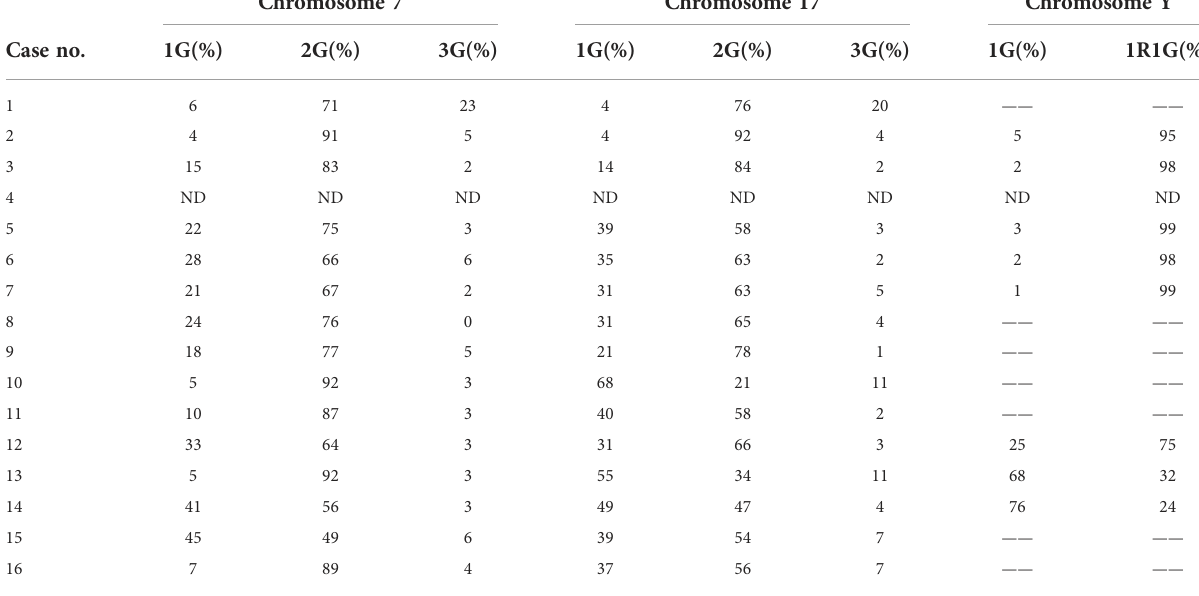
TABLE 4 Fluorescence in-situ hybridization fi ndings of